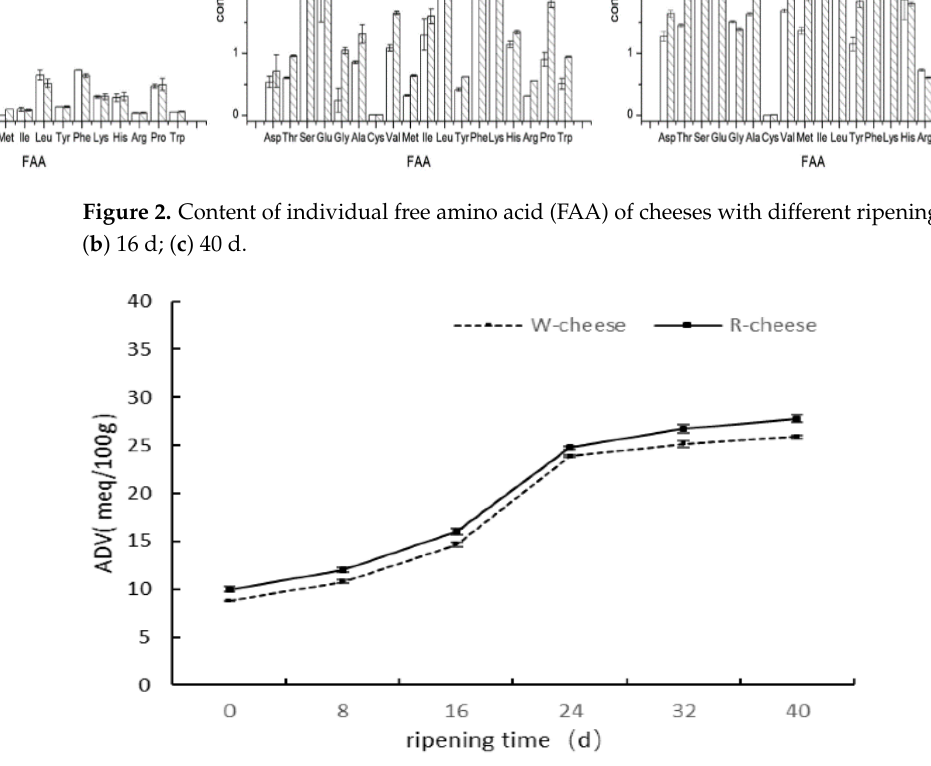
Figure 3. Changes of ADV of two cheeses with different ripening times.